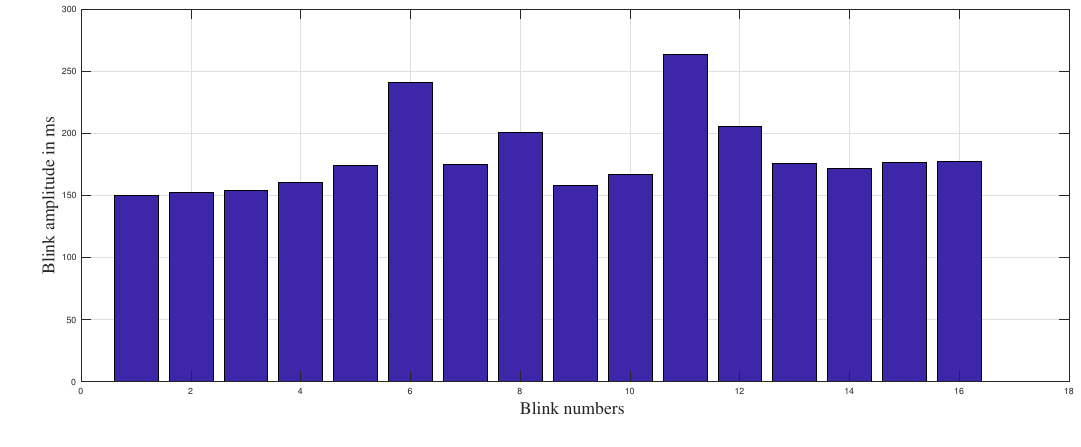
Figure 7. Blink amplitude y max